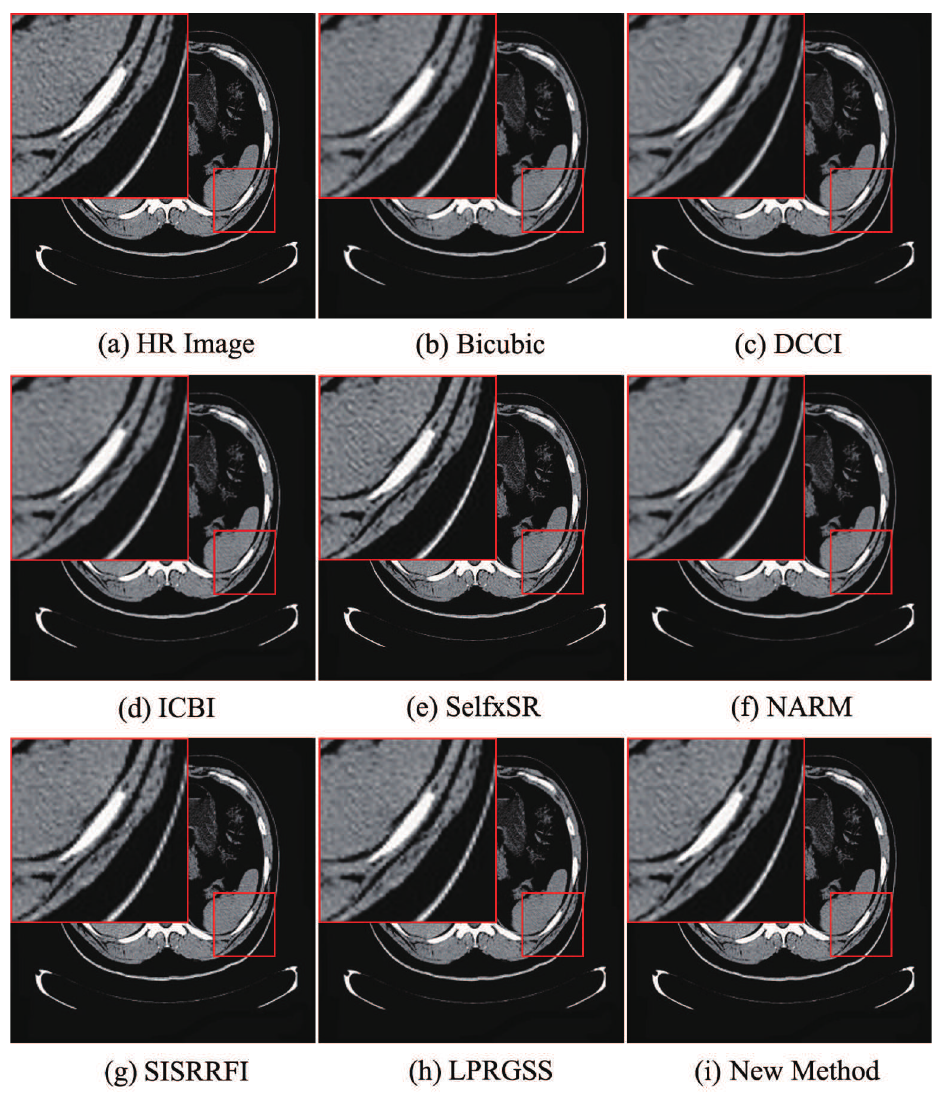
Figure 4. Chest images magnified by eight